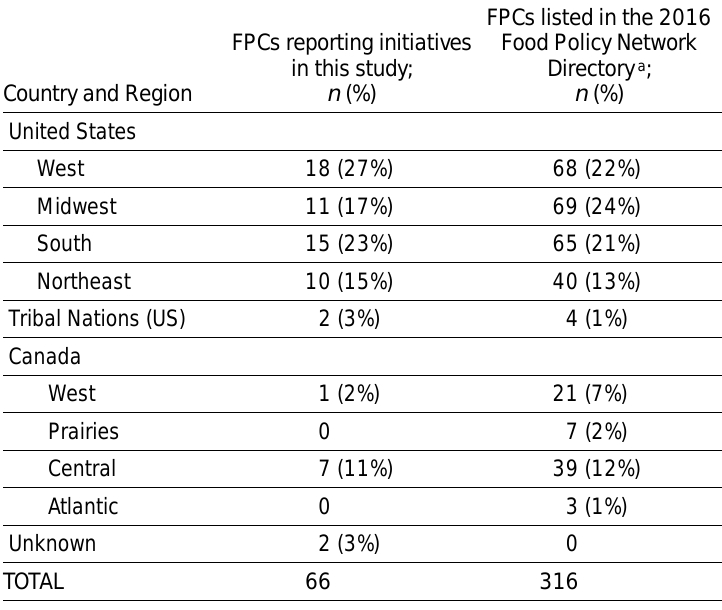
Table 1. Food Policy Councils (FPCs); Regional Distribution of Respondents to 2015 Survey ( N =66) Compared with Those Listed in the 2016 Food Policy Council